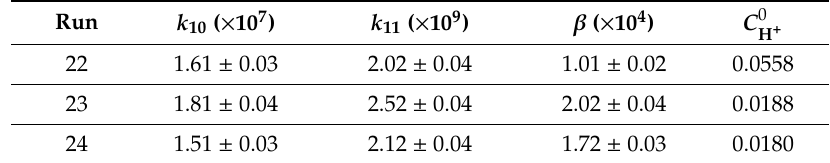
Table 6. Kinetic parameters used for simulating the runs performed in the absence of mineral